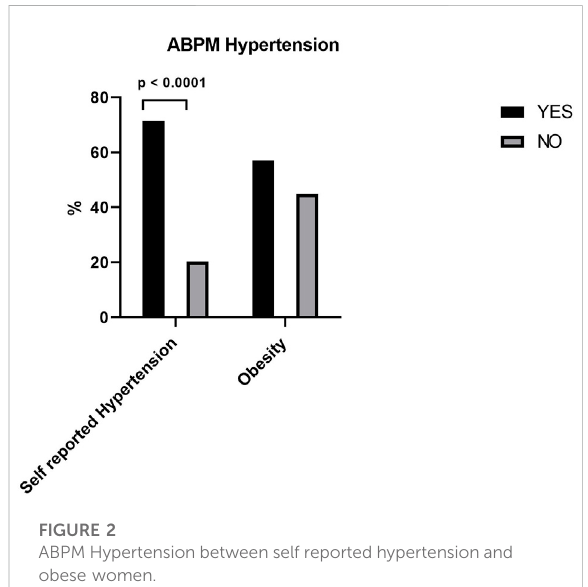
FIGURE 2 ABPM Hypertension between self reported hypertension and obese women.